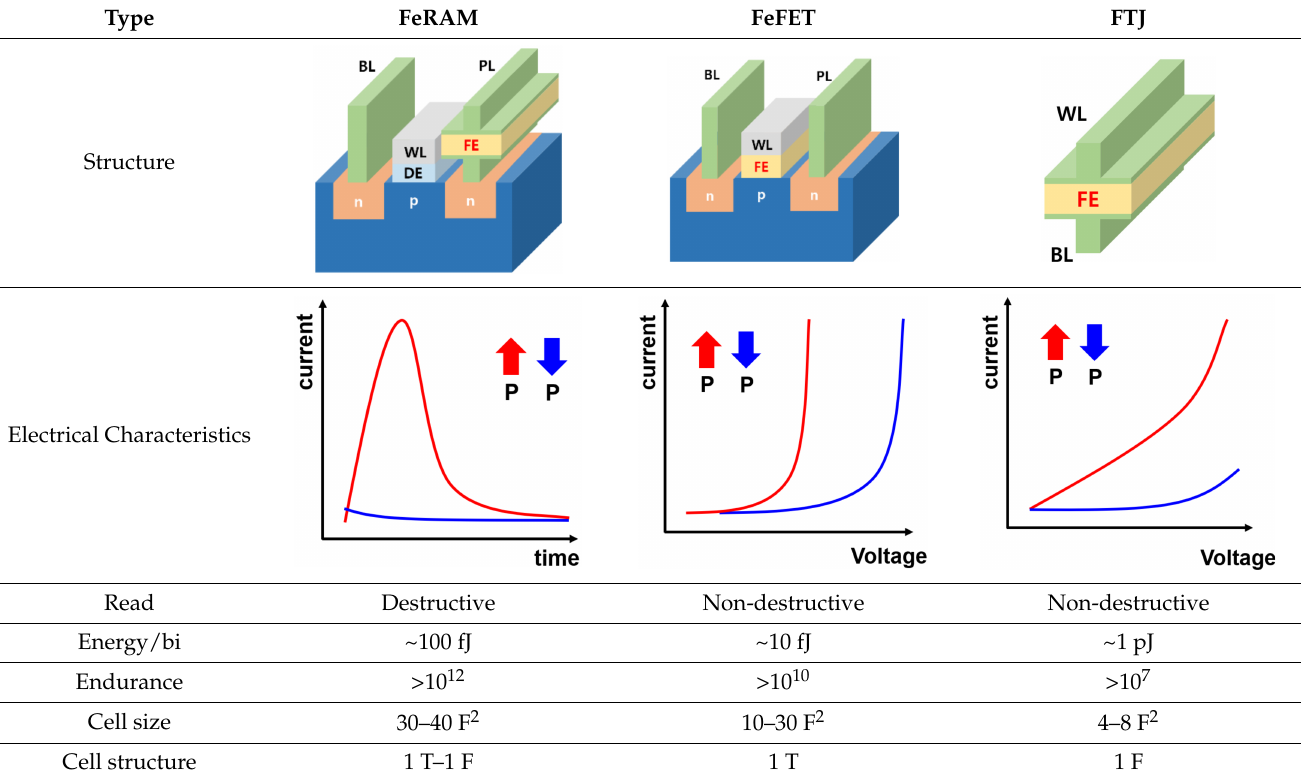
Table 1. Summary of NVM devices based on HfO 2 such as FeRAM, FeFET, and FTJ (BL: bitline, WL:wordline, PL: plateline, DE: dielectric layer, FE: Ferroelectric layer, n: n-type semiconductor, p: p-type semiconductor), data from [82].